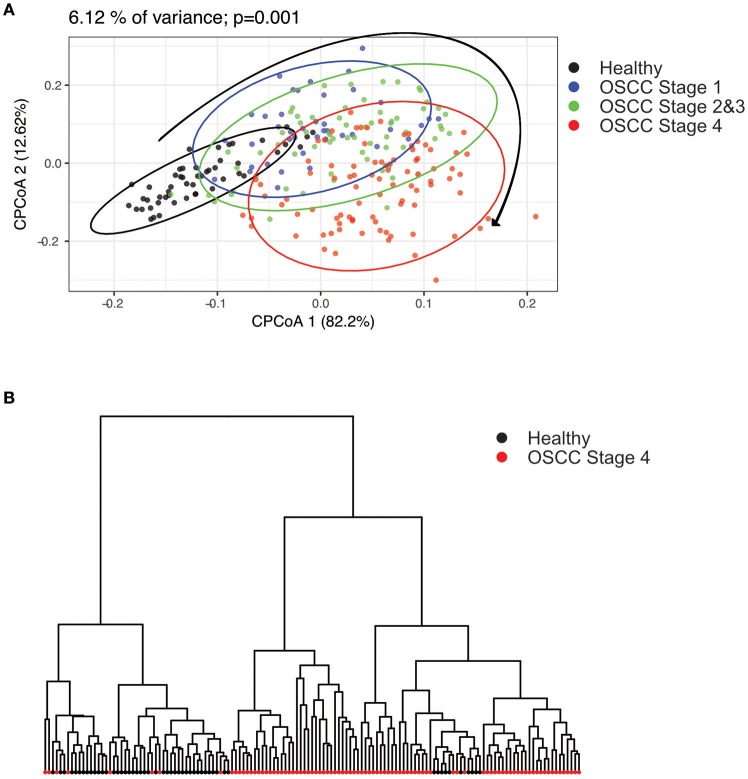
Principal component analysis (PCoA) and clustering analysis in healthy and OSCC patients. The oral microbiome compositions of healthy individuals and OSCC patients were analyzed using PCoA analysis and clustering analysis. (A) The individual samples are color coded to indicate healthy controls, stage 1, stages 2 and 3, and stage 4. The plot was analyzed and generated using the Bray-Curtis distances. (B) Hierarchical clustering was done using the healthy and OSCC stage 4 groups.